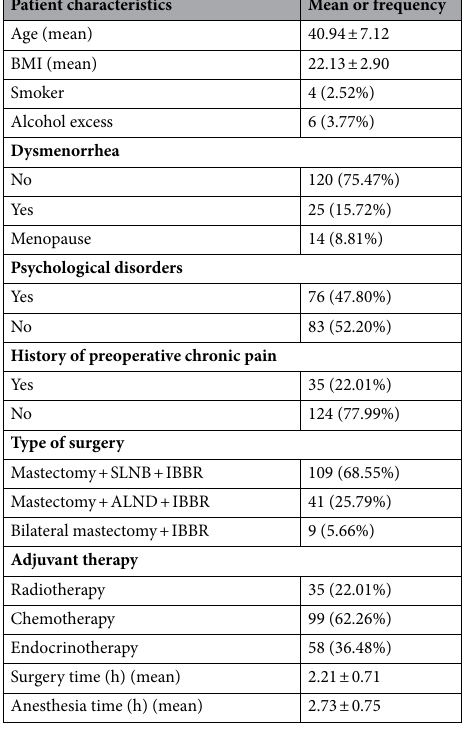
Table 1. Baseline characteristics. BMI body mass index, ALND axillary lymph node dissection, SNLB sentinel lymph node biopsy, IBBR implant-based breast